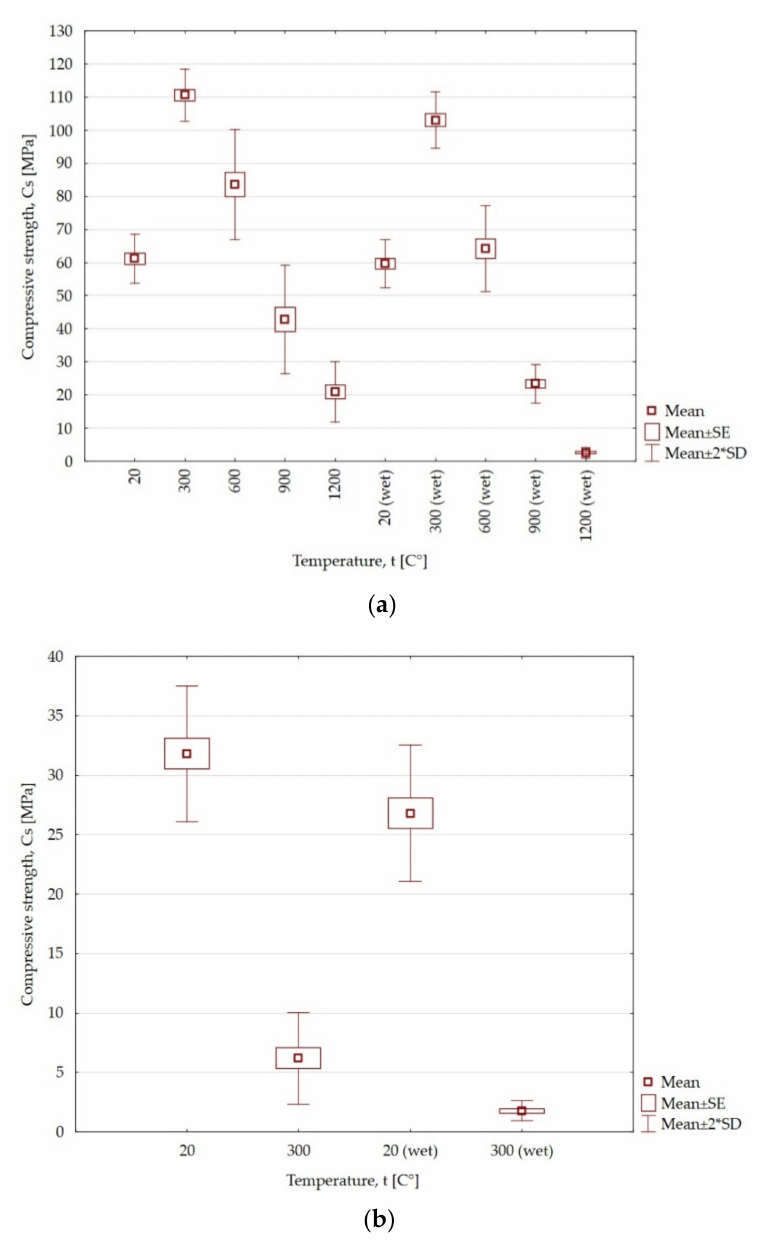
Figure 5. The influence of high temperatures on changes in uniaxial compression strength of dry and wet samples: ( a ) sandstone; ( b ) claystone; SE—standard error; SD—standard